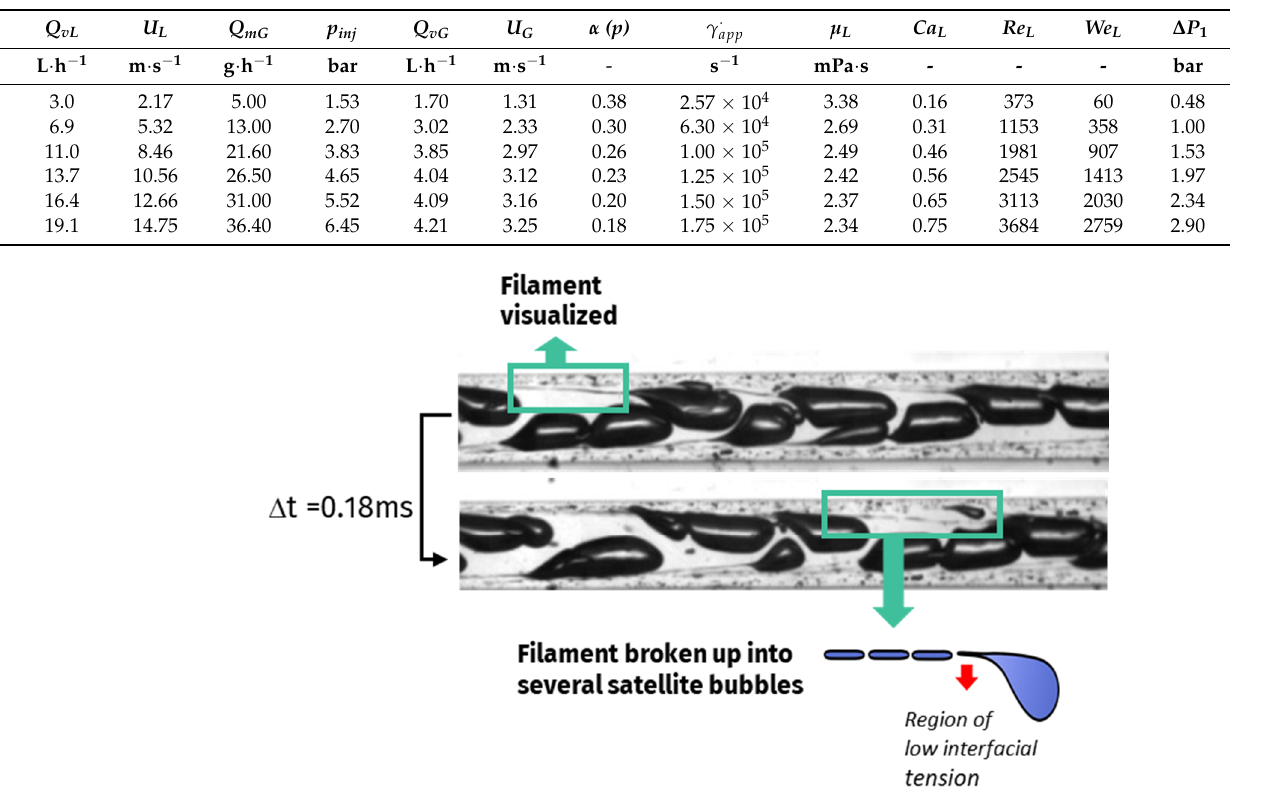
Figure 5. Tip-streaming bubble breakup mechanism identified in the mixing channel of all devices. Visualizations with the device CX600 at a liquid flowrate of 11 L/h. Liquid phase: model solution WPI3XG04. Gas phase: N 2 . At the bottom left: enlarged view of a bubble and its schematic representation. In the photos, a filament (circled in green) is shown before and after its break-up into satellite droplets; an interval of 0.18 s had elapsed between the two pictures.